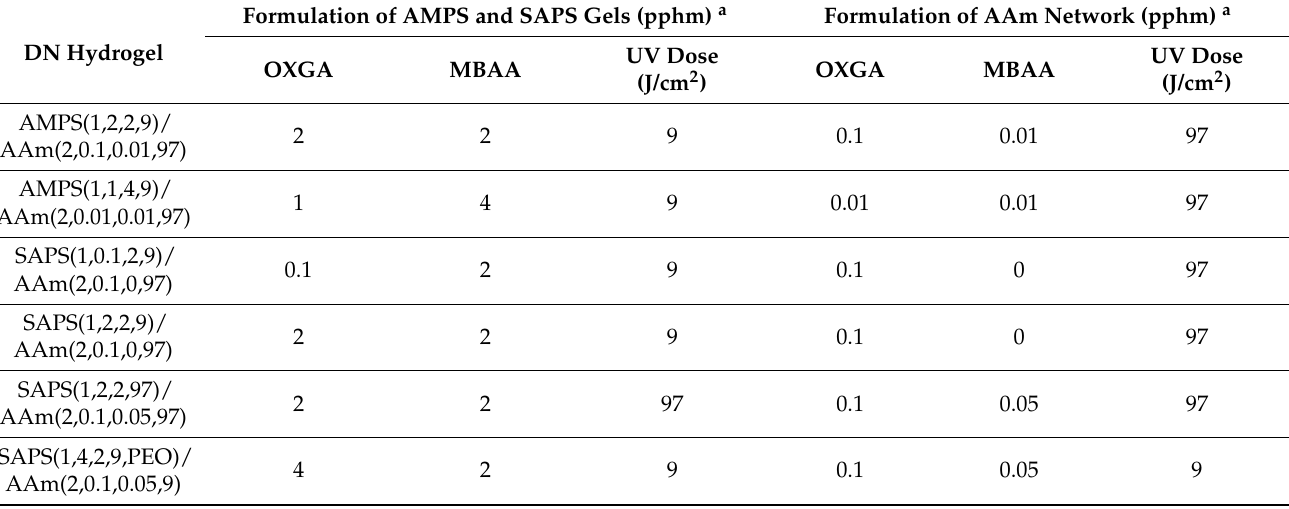
Table 1. DN hydrogels synthesized in this